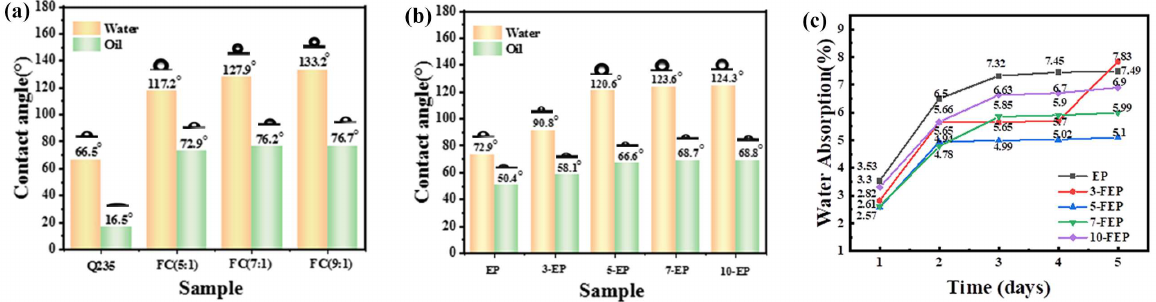
Figure 5. ( a ) the WCA and OCA for different scales of FC; ( b ) Composite coating of WCA and OCA; ( c ) Variation of water absorption of different coatings with soaking time.